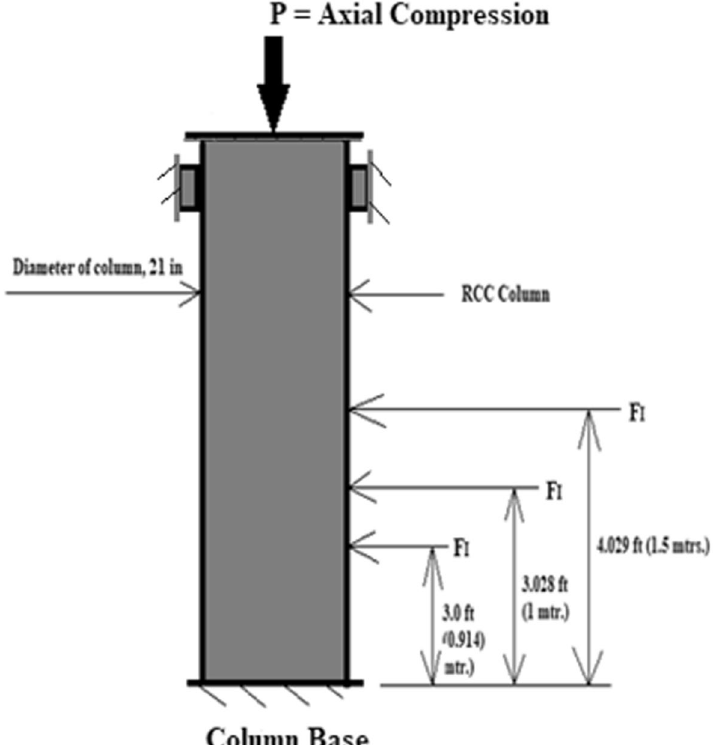
Fig. 8 Vehicular strike in column at different levels